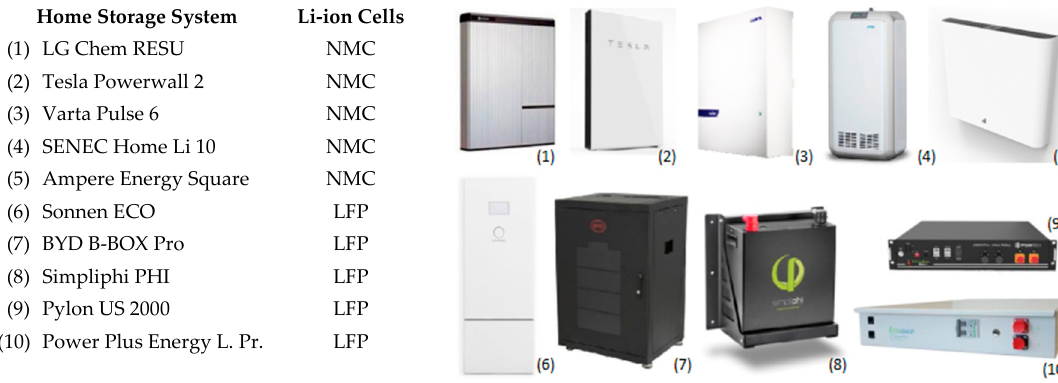
Figure 2. List of main home storage systems available in the market and type Li ‐ ion cells implemented.